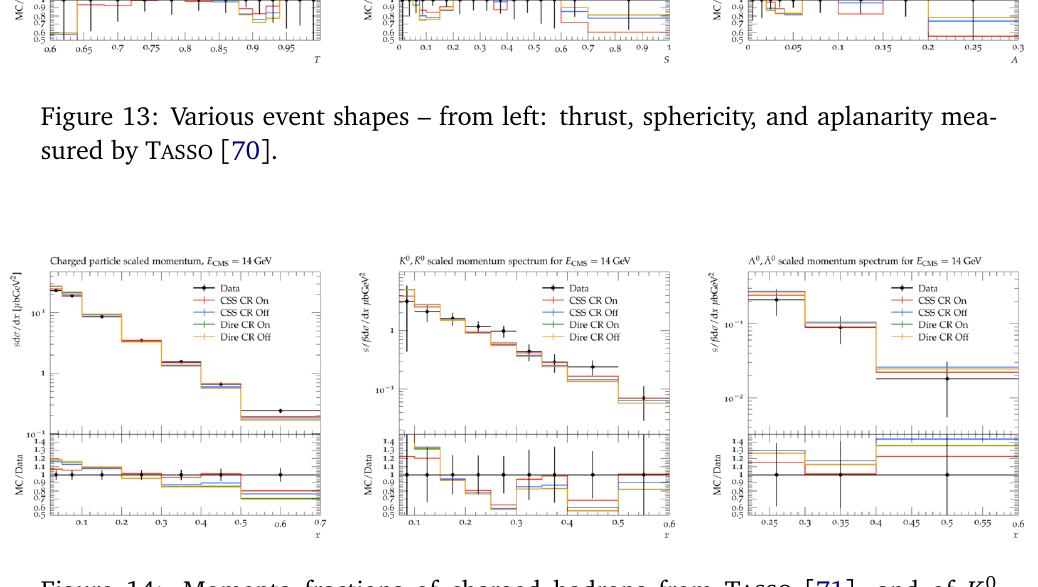
Figure 14: Momenta fractions of charged hadrons from T ASSO [ 71 ] , and of K 0 mesons, Λ 0 baryons, measured by T ASSO [ 72 ]